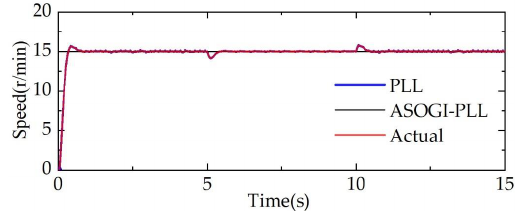
Figure 16. Speed waveform during sudden load change.